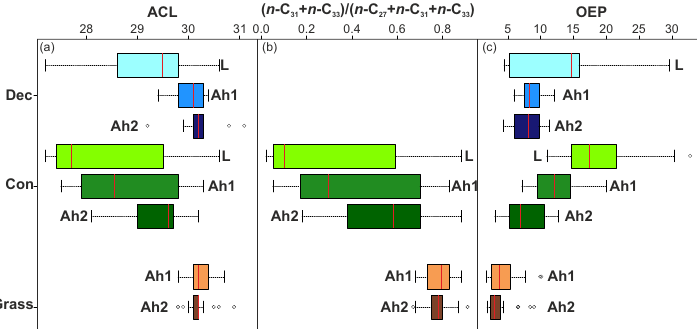
Figure 4. Box plots of (a) n -alkane ACL, (b) ( n -C 31 + n -C 33 )/( n -C 27 + n -C 31 + n -C 33 ) ratio, and (c) OEP. Con: coniferous forest sites ( n = 9); dec: deciduous forest sites ( n = 14); grass: grassland sites ( n = 22); L: litter; Ah1: topsoil 1 (0–3cm); Ah2: topsoil 2 (3–10cm). Box plots show median (red line), interquartile range (IQR) with upper (75%) and lower (25%) quartiles, lowest datum still within 1.5 × IQR of lower quartile, and highest datum still within 1.5 × IQR of upper